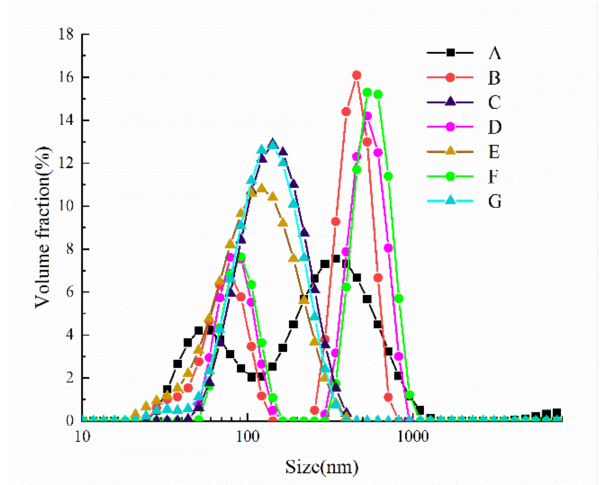
Figure 1. Particle size distribution of oxidized SPI before and after cavitation jet